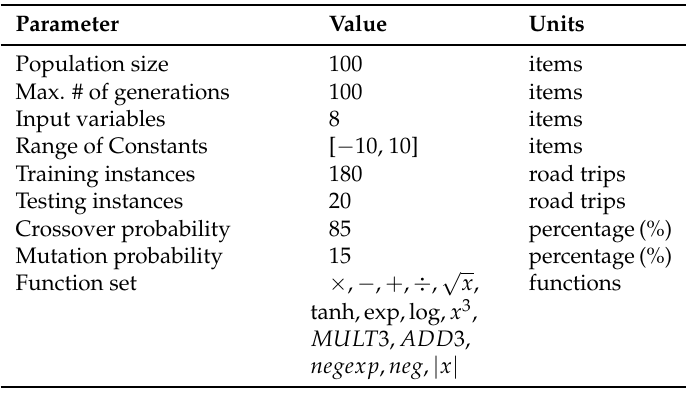
Table 2. Parameters for GPTIPS, neatGP and neatGP-LS.